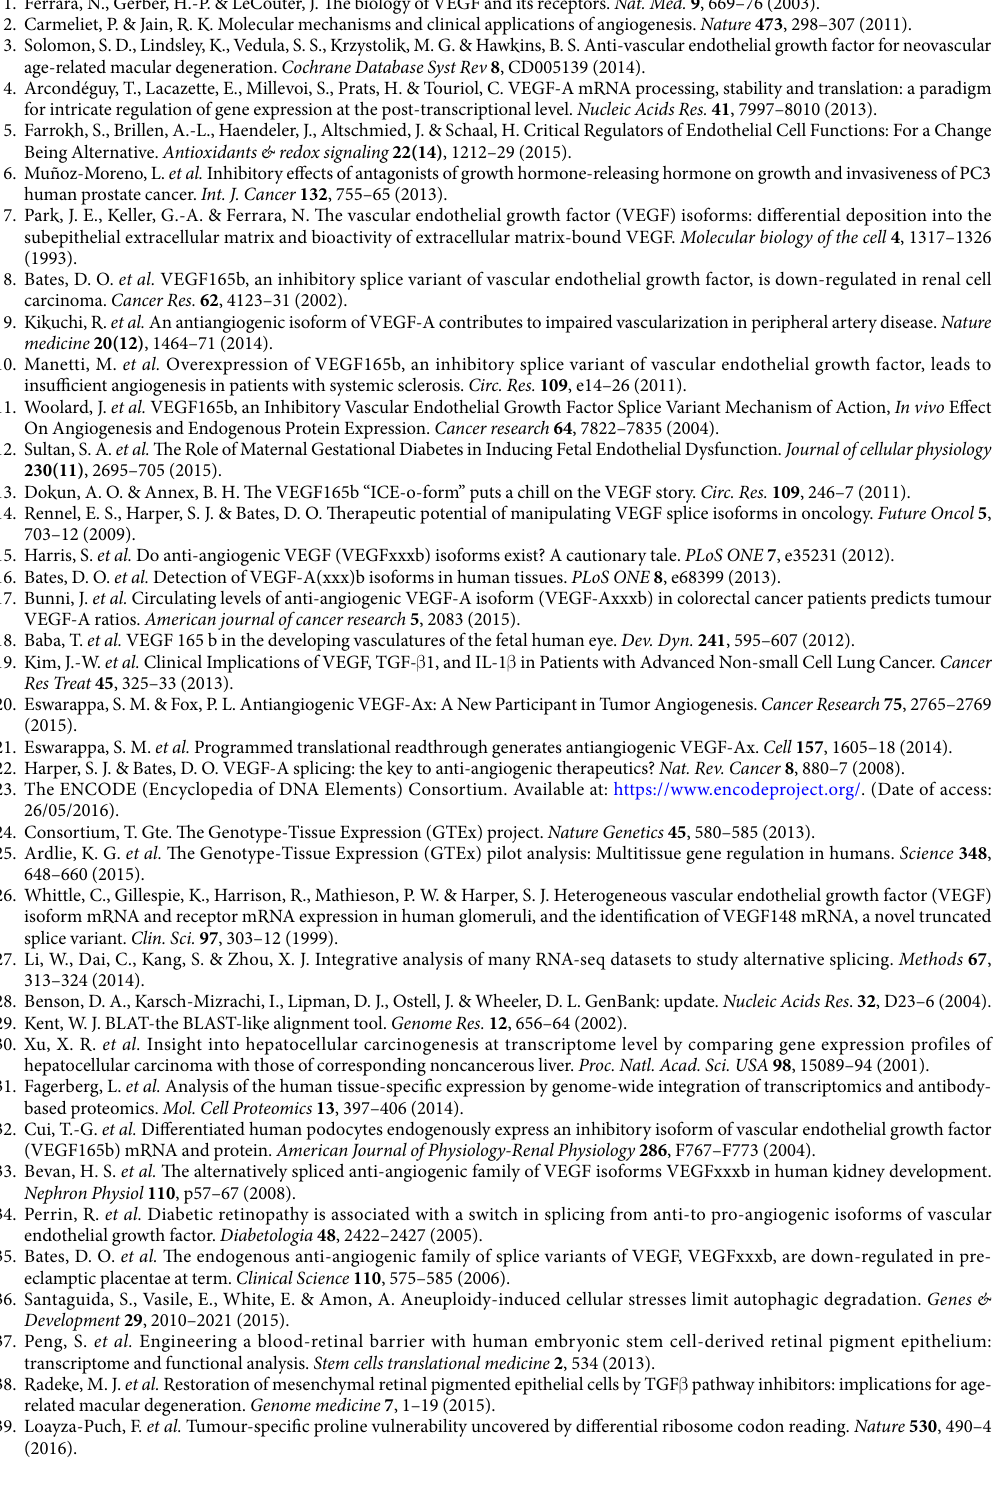
protocol. Libraries were quantified using the PerfeCTa NGS Quantification Kit for Ion Torrent libraries (Quanta Biosciences). Template preparation was performed on the OneTouch 2 system (Life Technologies) using the Ion PGM Template OT2 200 Kit and protocol version A.0 as recommended by the manufacturer’s instructions (Life Technologies). Sequencing was performed on Ion Torrent PGM (Life Technologies) using the Ion PGM HI-Q Sequencing kit and an Ion 314 Chip Kit V2, following the manufacturer’s instructions (version B.0). TruSeq stranded mRNA-seq libraries were prepared from total RNA by Edinburgh Genomics, The University of Edinburgh and sequenced on a MiSeq (v2